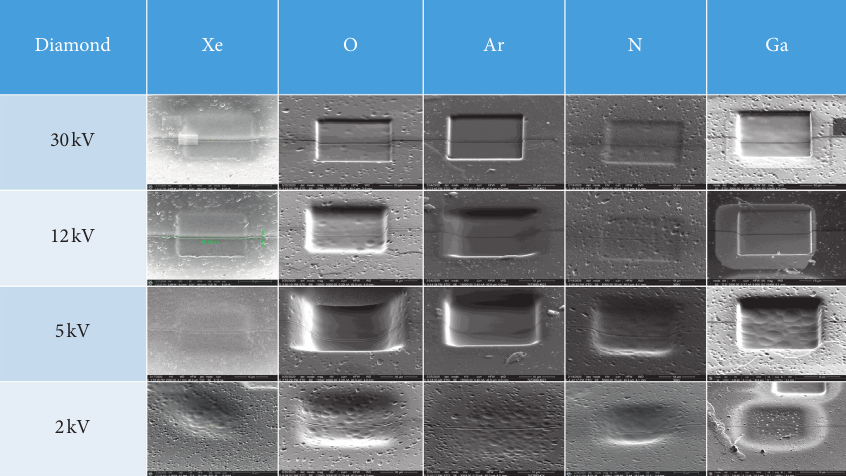
Figure 14: All images of diamond milled with different ion species at varying energies. Area is held constant at 20 µ m 2 . For beam current values, refer Table 1. All images were captured with a horizontal field width of 41.4 µ m.